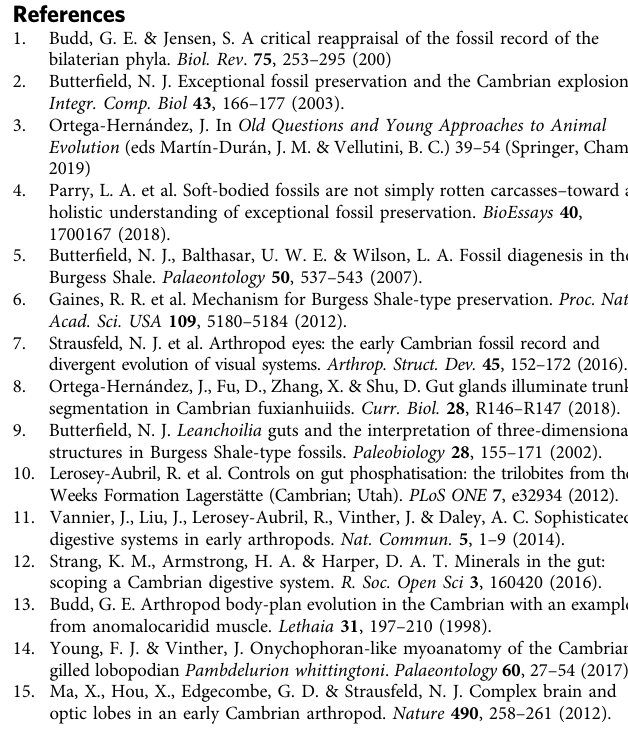
Fig. 5 Evolution of the central nervous system in Panarthropoda. Known neuroanatomical organization depicted in purple. Crosses indicate extinct clades. a Simpli fi ed tree topology showing the position of Mollisonia and Megacheira as members of stem-group Chelicerata, based on the results of the phylogenetic analyses under both Bayesian inference and maximum parsimony (Supplementary Fig. 5); this hypothesis produces the most parsimonious reconstruction of the evolution of the central nervous system. b . Alternative tree topology showing the position of Mollisonia within stem-group Chelicerata, and megacheirans as stem- group Euarthropoda (e.g., refs. 34, 43 ) this topology implies convergent evolution of the central nervous system between megacheirans and crown-group chelicerates, and was not recovered in our phylogenetic analyses. Sources for neuroanatomical data: Onychophora 71 , Tardigrada 72 , Radiodonta 17 , Fuxianhuiida 15,19 , Megacheira 16,22 , Chelicerata 43 , Mollisonia (this study), Mandibulata 47 . Character coding is available in the Supplementary Note. Morphological data set of 54 taxa and 106 characters available in the Supplementary Data 1. post. connec. posterior connectives, single op. n. single optic neuropil